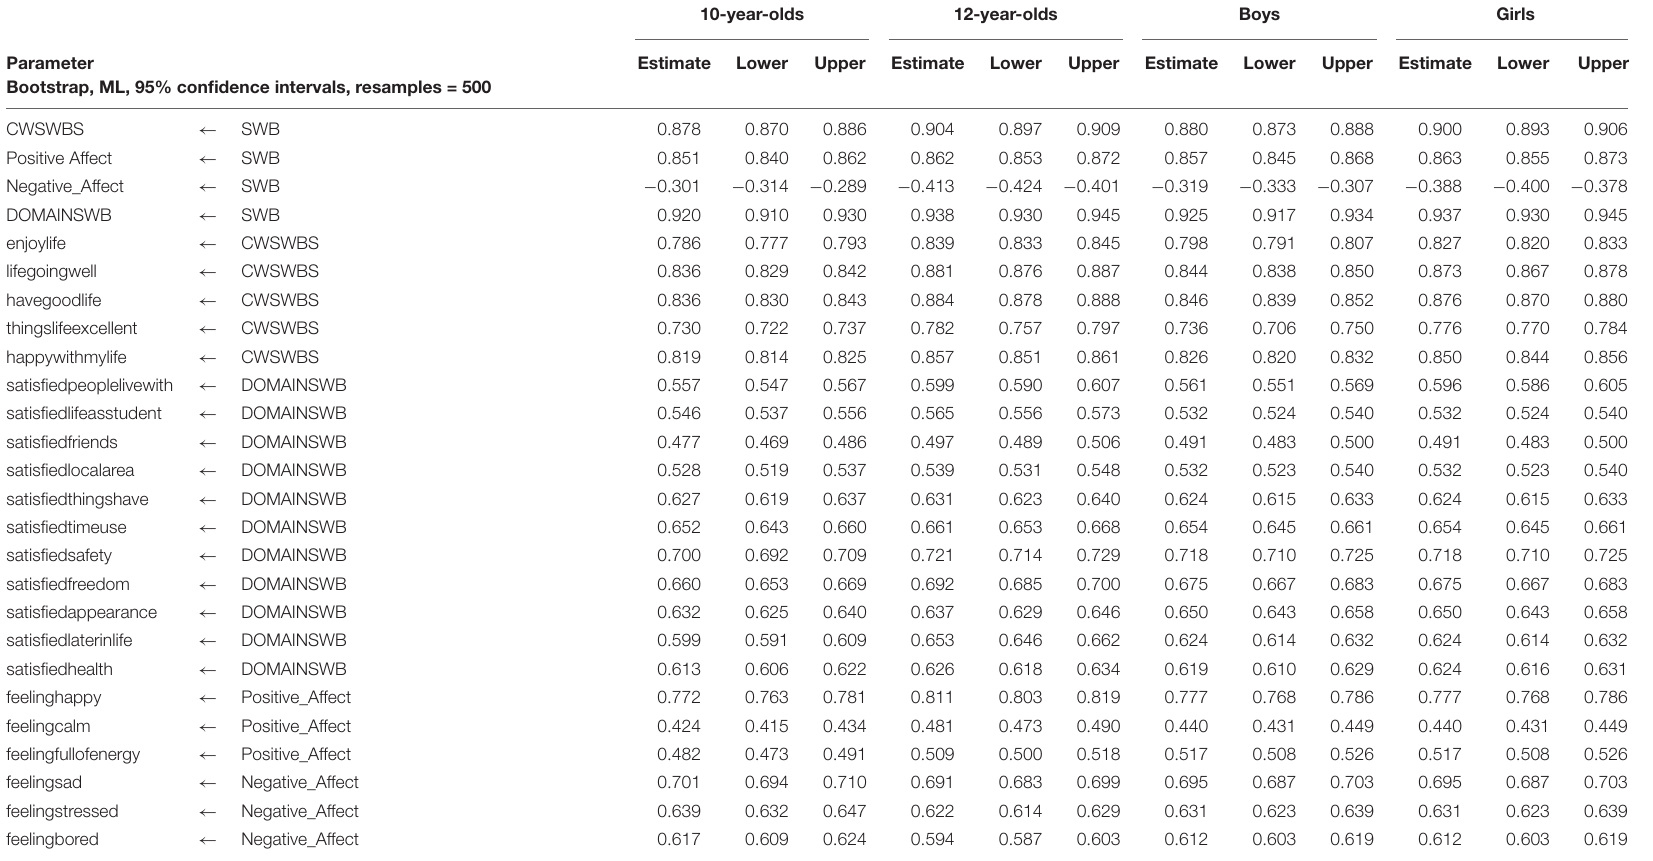
TABLE 6 | Standardized regression weights: metric model with constrained loadings (age and gender).